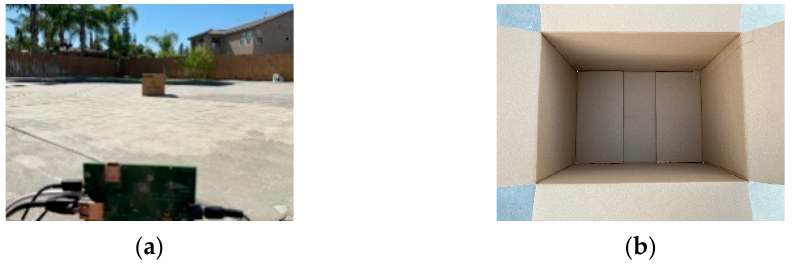
Figure 3. ( a ) The measurement setting with radar and ( b ) an empty box.